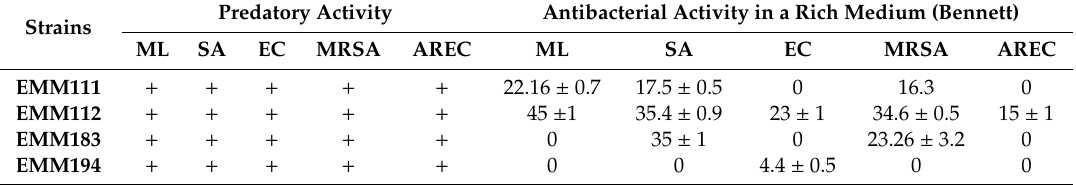
Table 2. Comparison of the predatory activity and the antibacterial activity on rich medium of four predatory Actinobacteria isolates.